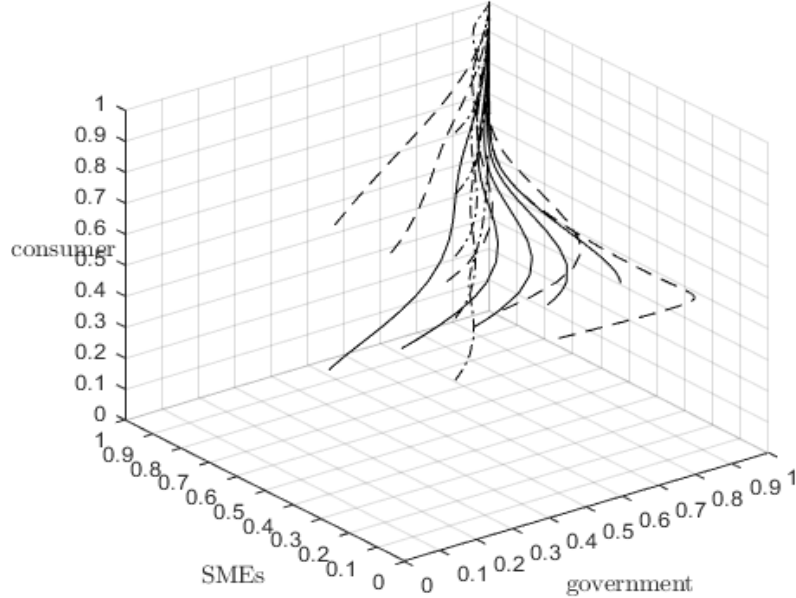
Figure 6. Government regulatory agencies–SME–consumer after public health emergencies (Three-dimensional stereogram).